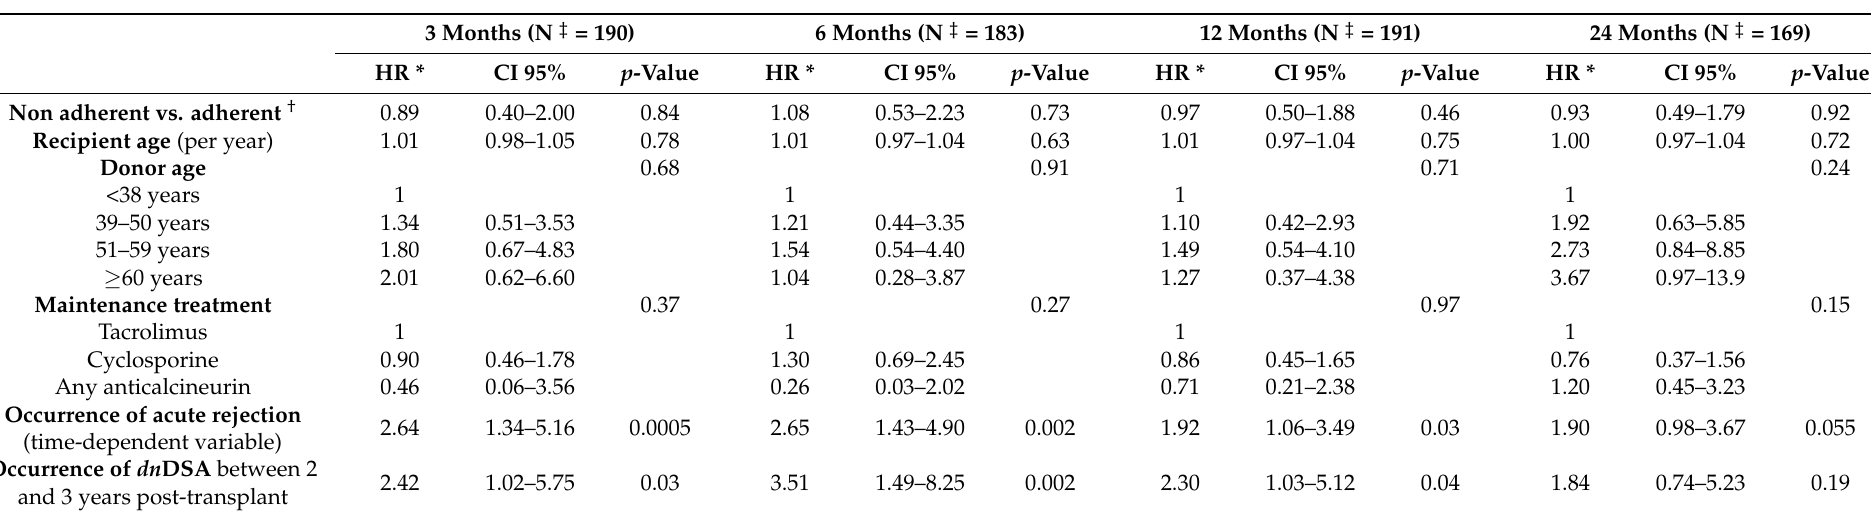
Table 4. Effect of non-adherence measured by the Morisky scale and immunosuppression regimen (tacrolimus/cyclosporine/any anticalcineurin) on the hazard of graft failure since the third year post transplantation. Results of Cox proportional hazard model. Multivariable